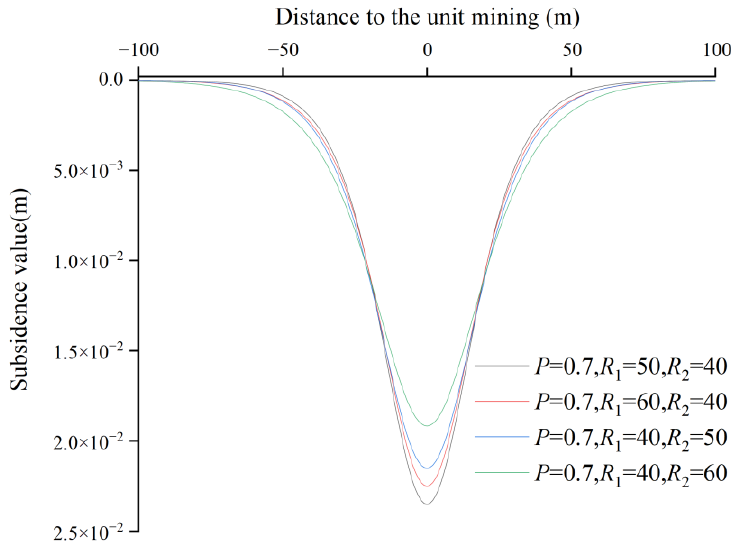
Figure 4. The relationship between the main influence radii R 1 , R 2 , and the unit mining subsidence values.